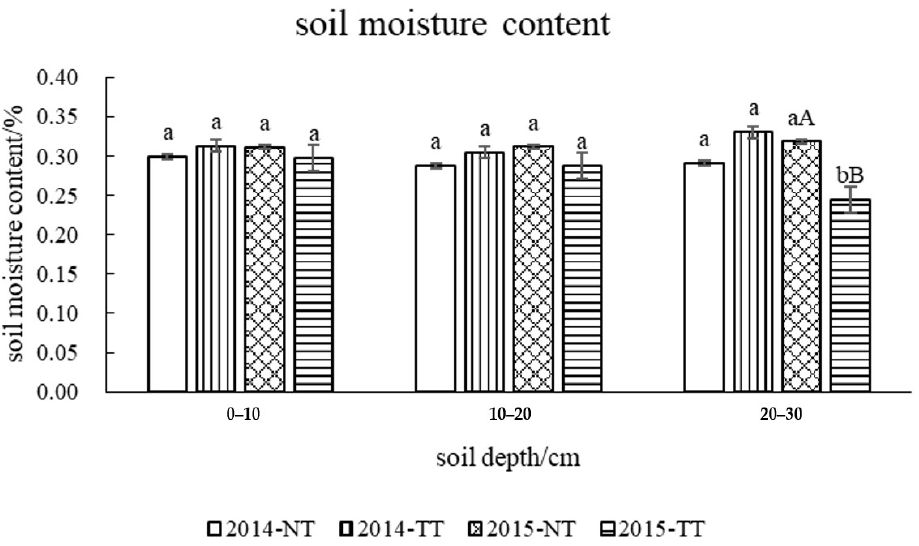
Figure 3. Mean soil moisture content of NT and TT treatments in 0–10 cm, 10–20 and 20–30 cm depths in 2014 and 2015. Samples were taken immediately after maize harvest in October every year. Means within each depth followed by the same letter were not significantly different ( p > 0.05); NT: no tillage with straw cover; TT: traditional tillage with conventional ploughing.